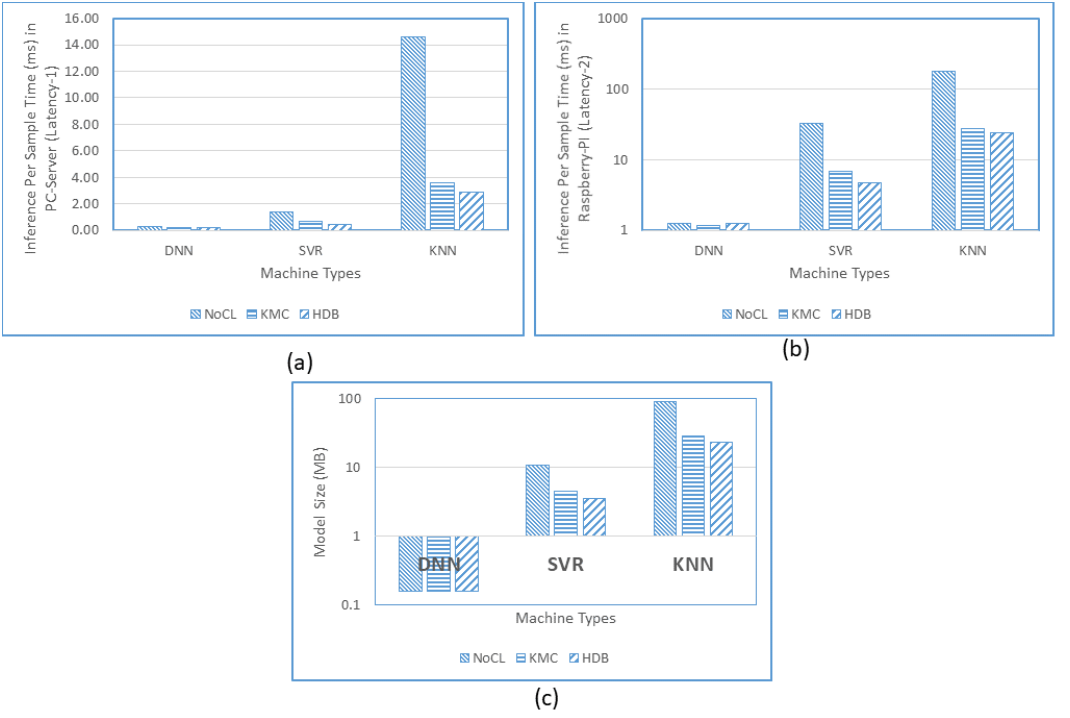
Figure 18. Inference Per Sample Time of Latency-1 ( a ), Latency-2 ( b ), and Model Size ( c ) Comparisons of the DNN, SVR, and